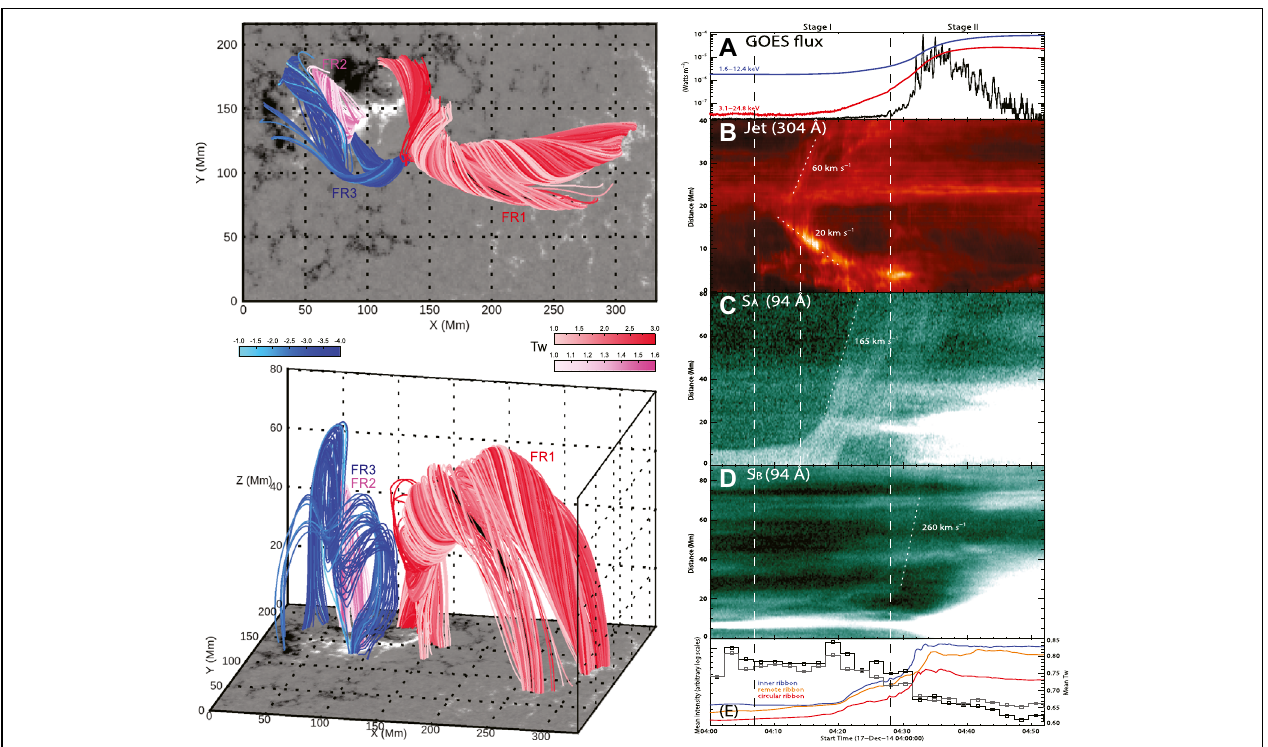
FIGURE 5 | Left: the NLFFF field lines at a preflare time in the top view (top) and a perspective view (bottom). The colors represent T w , and a different color table is used for T w in each flux rope. Right: the GOES lightcurves and the time derivative of the 1.6–12.4 keV passband flux (A) . Time-distance plots for a curved slit (B) , and two linear slits, SA (C) , and SB (D) . Time profiles of the average 304 Å intensity of ribbons and the average T w in the northern (black) and southern (gray) footpoint regions of FR2 (E) . The dashed vertical lines denote stages I and II, respectively. (Source: Liu et al., 2019, Figures 4,